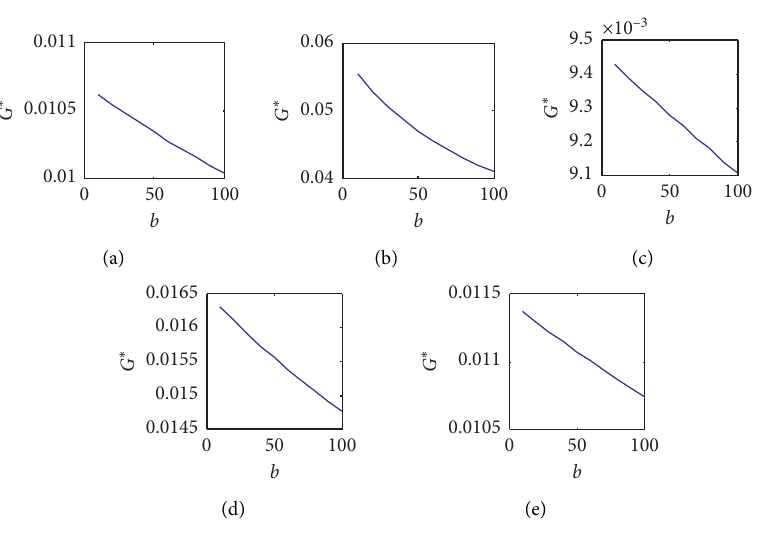
Figure 1: b versus G ∗ graph. (a) Problem 1. (b) Problem 2. (c) Problem 3. (d) Problem 4. (e) Problem